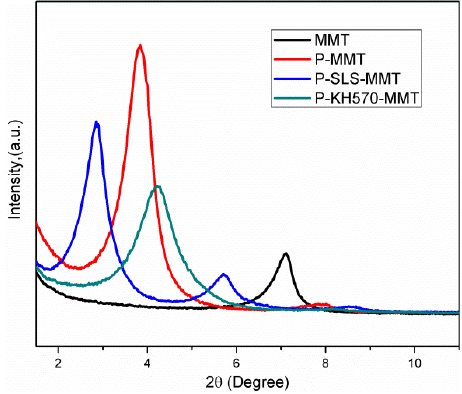
Figure 3. XRD patterns of MMT, P-MMT, P-SLS-MMT, and P-KH570-MMT.